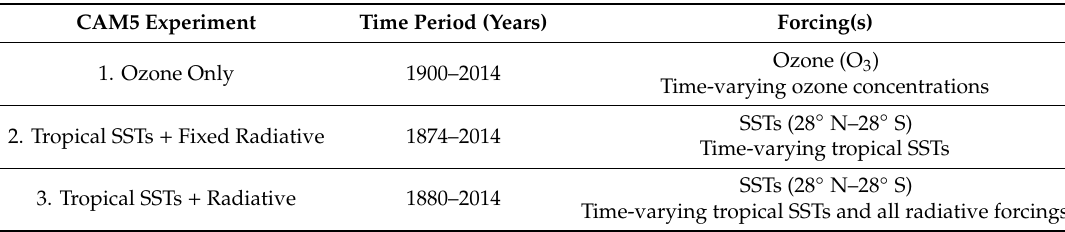
Table 1. List of CAM5 model experiments, their available time periods and external forcing mechanisms that characterize each